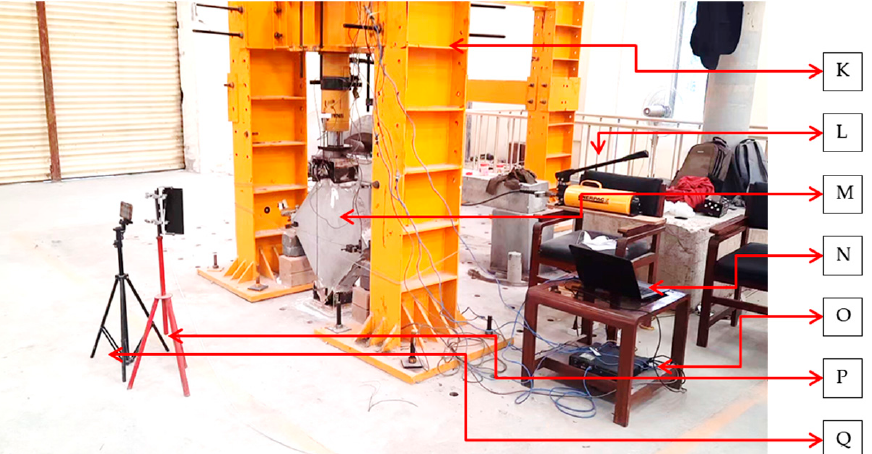
Figure 6. Diagonal tension (shear) testing setup: (K) shear frame (100-ton axial capacity); (L) hydraulic pump; (M) masonry wallet (test sample); (N) laptop for data reading and recording; (O) data logger; (P) lamp; (Q) video recording equipment.